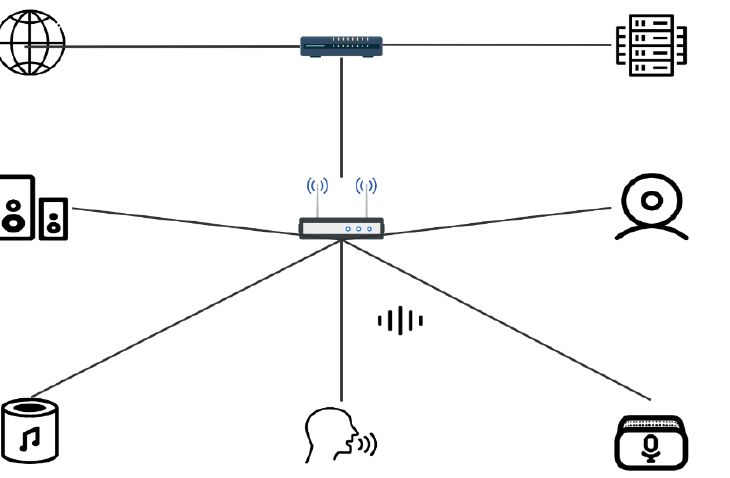
Figure 9. Secure Audio Encryption Application in Smart home.